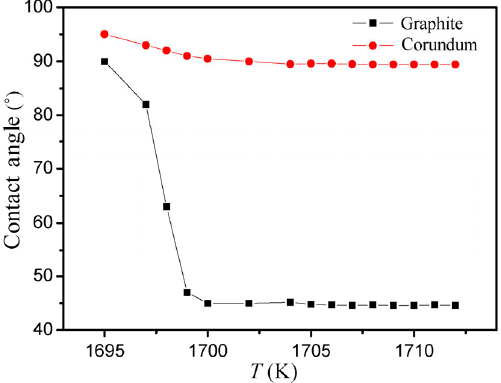
Fig. 10 θ curves of molten silicon on polished graphite and corundum surface (Ar).